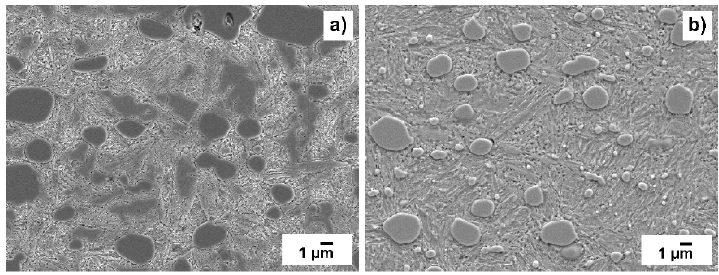
Figure 3. Microstructure of X210Cr12 tool steel after: “A” treatment ( a ); and “C” treatment ( b ). Table 2. Hardness of the tested samples after heat treatment (HRC). Heat Treatment After Quenching After Tempering “A” 62 ± 1 61 ± 1 “C” 53 ± 0.8 57 ± 0.8